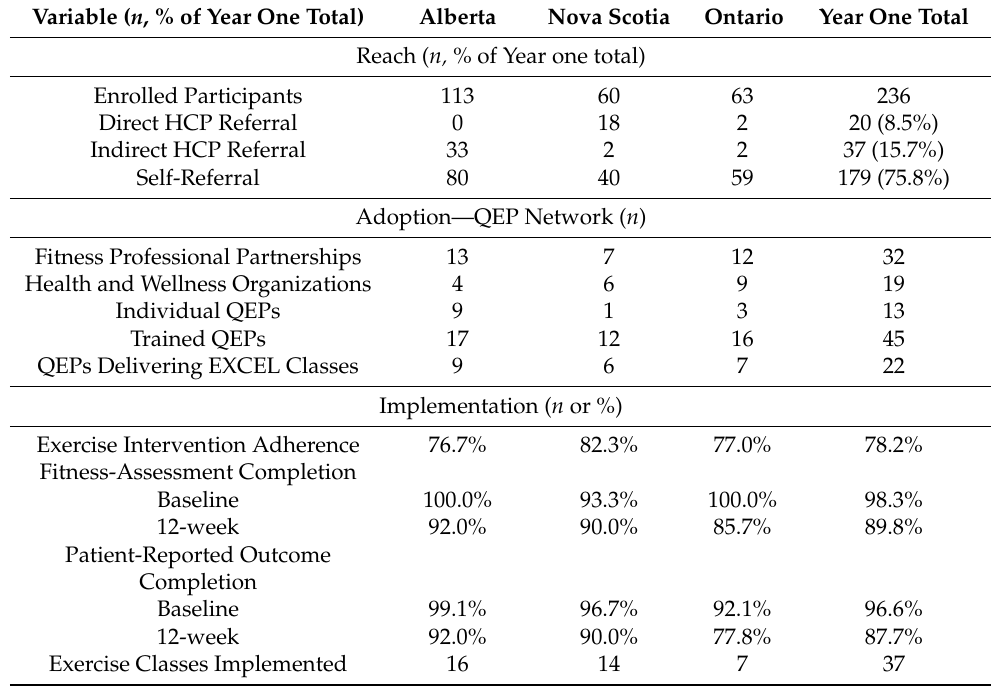
Table 2. Reach, adoption (QEP), and implementation